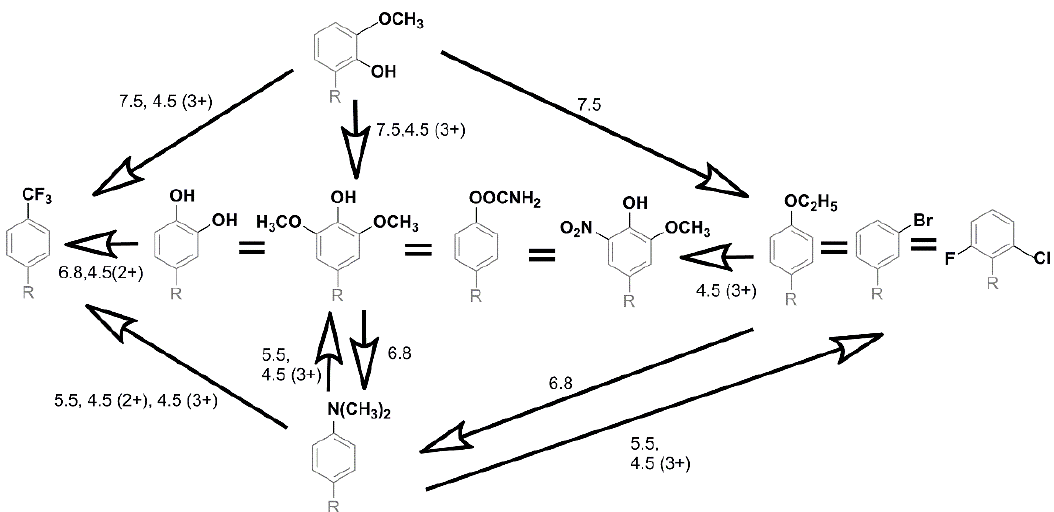
Figure 3. Summary of the differences in iron chelation among the tested compounds. The direction of the arrows shows more active compounds. The numbers represent pH at which the differences were observed; at pH 4.5, the oxidative state is mentioned in parentheses.